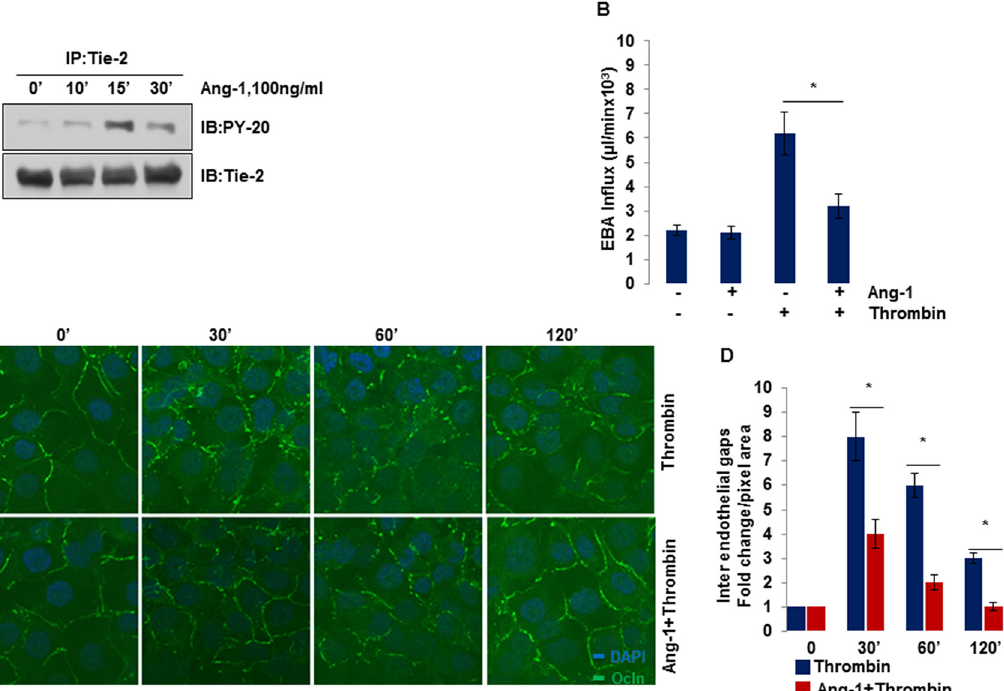
Fig 1. Ang-1 prevents disruption of inter-endothelial junctions and endothelial hyper-permeability induced by thrombin. ( A) Serum starved HBMECs were stimulated with 100ng/ml of Ang-1 for different times. Tyrosine phosphorylation level of Tie-2 was determined by immunoprecipitating Tie-2 followed by Western blotting for PY-20 antibody. ( B) Transendothelial EBA tracer permeability was determined in serum starved HBMECs unstimulated or stimulated with Ang-1 (100ng/ml for 15 min) or with thrombin (100nM for 120 min) or incubated with Ang-1 followed by thrombin treatment. Bar graphs show the average ± SEM, * P < 0.05. ( C) HBMECs were treated with 100nM thrombin alone or after Ang-1 (100ng/ml for 15 min) for indicated times. Cells were fixed, permeabilized and stained for Occludin. Immunofluorescent staining and confocal microscopy was performed as described in Methods. Scale bar = 10 μ M. (D) Quantification of number of inter-endothelial gap (shown as fold change quantified using Occludin staining described in ( C ), * P < 0.05.